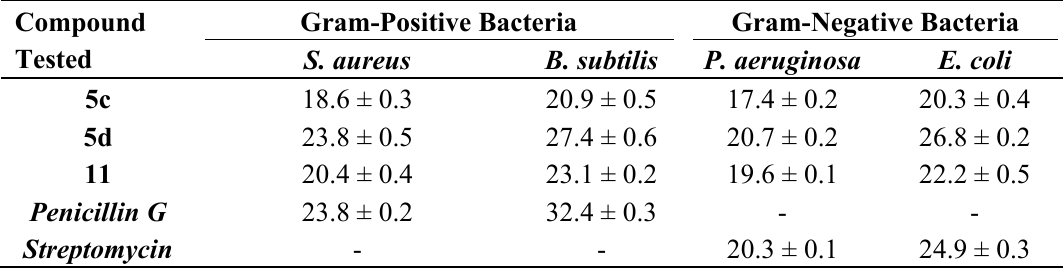
Table 2. Antibacterial activities of the synthesized compounds 5c , d and 11 . Compound Tested